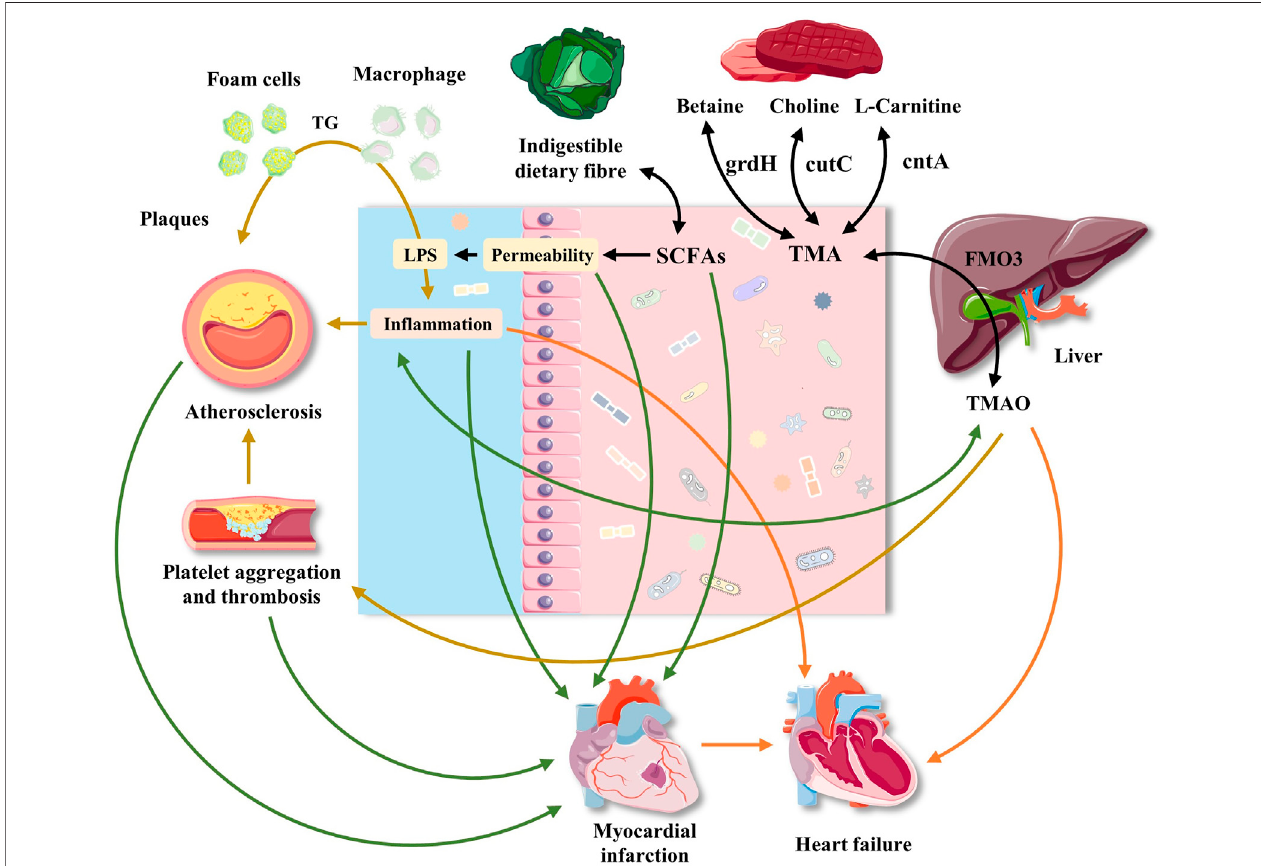
FIGURE2| Effects ofgut microbiota and its metaboliteson atherosclerosis,myocardialinfarction,heart failure and hypertension. Theinteractionbetween dietand gut microbiota may promote the development of cardiovascular disease through common and different mechanisms. Western food rich in red meat promotes the production of TMA by bacteria, which is oxidized to TMAO in liver. TMAO may participate in atherosclerosis by interfering with cholesterol transport, foam cell formation and platelet aggregation. The effect ofTMAO on blood pressure wasmainly manifested in its enhancement ofpressure-raizing effectofAng II. Platelet aggregation also plays a role in atherosclerosis. The decrease of dietary fi ber is related to the decrease of bacterial production of SCFAs, which play an immunomodulatory role in intestinal mucosa. The decrease of SCFAs level can promote local in fl ammation, aggravate intestinal ecological imbalance, and lead to the damage of intestinal barrier function.Thedamageofintestinalbarrierfunctionleadstotheleakageofbacterialtoxins,whichfurtheraggravateslocalandsystemicin fl ammation.Inaddition,dysbiosis destroys the intestinal mucosal barrier, leading to gut microbiota entering the systemic circulation, which increases the incidence of adverse cardiovascular events after MI and aggravates the progress of HF. The roles of gut microbiota and its metabolites in hypertension.